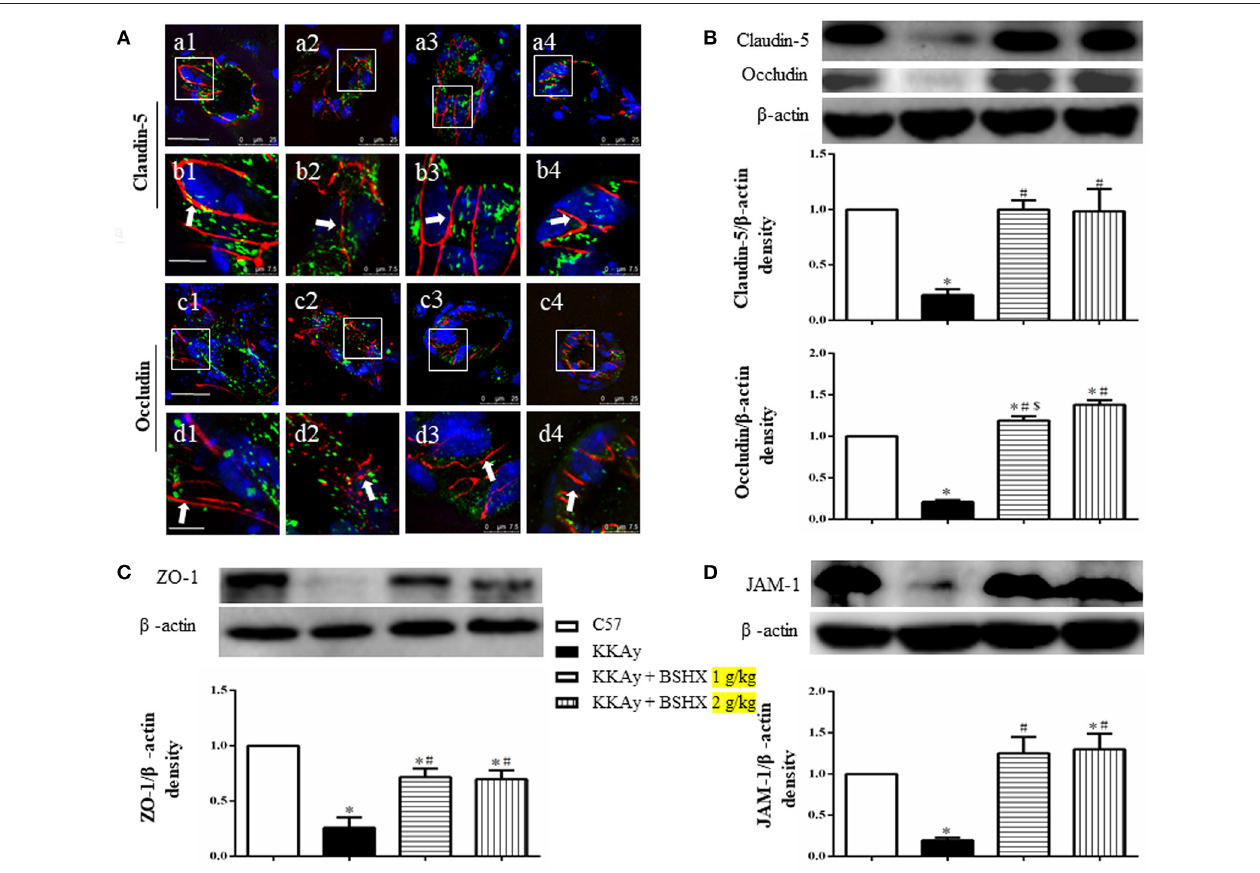
FIGURE 8 | The effect of BSHX on TJ proteins expression in vascular endothelial cells. (A) Representative immunofluorescence confocal images of claudin-5 (a1–b4, red), occludin (c1–d4, red) localized at the periphery of endothelial cells with marker vWF (green). Arrows indicate the localization of claudin-5 or occludin. a1: C57 group; a2: KKAy group; a3: KKAy + BSHX 1 g/kg group; a4: KKAy + BSHX 2 g/kg. TJ: tight junction. Bar (a1,c1) = 25 µ m; Bar (b1,d1) = 7.5 µ m. (B) Representative Western blots and quantitative analysis of claudin-5 and occludin. (C) Representative western blots and quantitative analysis of ZO-1. (D) Representative western blots and quantitative analysis of JAM-1. Data were expressed as mean ± SD ( n = 5). * p < 0.05 vs. C57 group, # p < 0.05 vs. KKAy group, $ p < 0.05 vs. KKAy + BSHX 2 g/kg